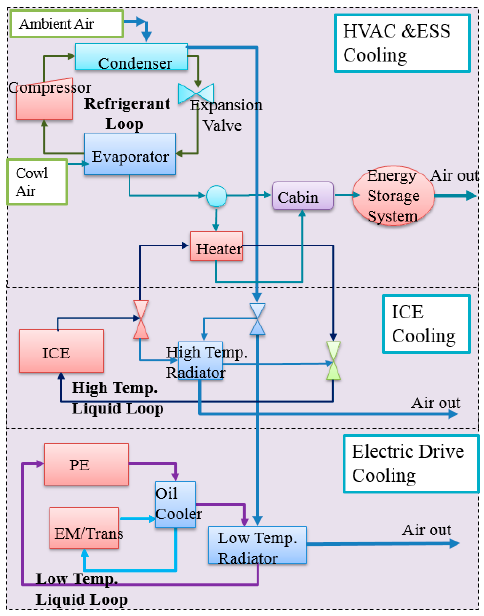
Figure 8. ITM introduced by NREL [151].